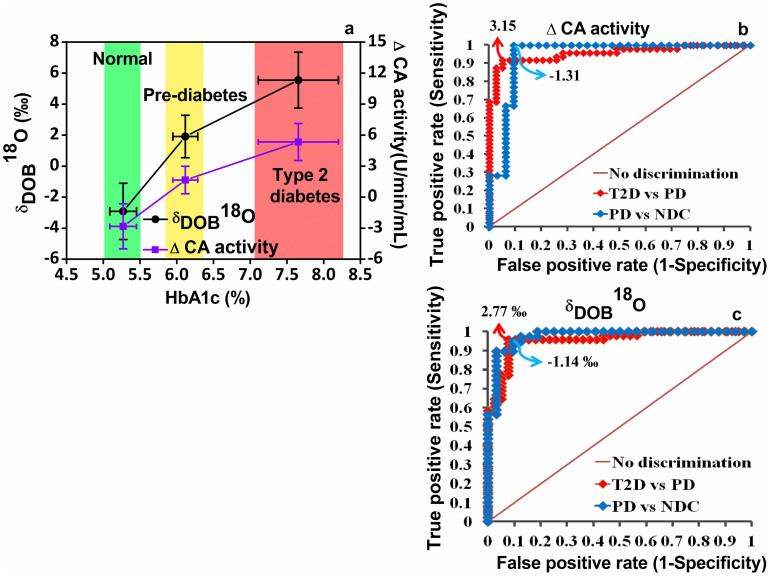
Distribution of ΔCA activities and δDOB
18O values against HbA1c (%) for non-diabetic control (NDC), pre-diabetes (PD) and type 2 diabetes (T2D).(a), Plot represents the clear transitions of ΔCA activities and δDOB
18O from NDC (green) to PD (yellow) and T2D (red). (b), (c), From receiver operating characteristic (ROC) curves analysis, the optimal diagnostic cut-off points were determined. The ΔCA activity <−1.31 for NDC; ΔCA activity >3.15 for T2D and −1.31 ≤ ΔCA activity ≤ 3.15 for PD, whereas δDOB
18O ‰ <−1.14 for NDC; δDOB
18O ‰ >2.77 for T2D and −1.14 ≤ δDOB
18O ‰ ≤ 2.77 for PD. Data are means ± SD.